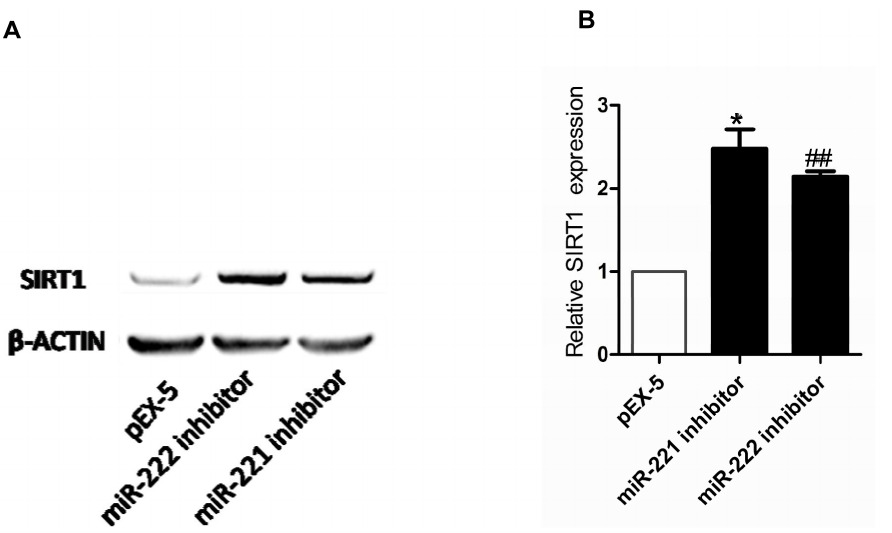
Figure 6. Effect of miR-221 inhibitor or miR-222 inhibitor on expression of SIRT1 protein. ( A ) Expression of SIRT1 protein levels in PC-3 cells after transfection were determined by Western blot analysis. ( B ) Quantitation of SIRT1 protein expression. Data represent the mean value 6 SEM from three separate experiments. * P , 0.05 vs pEX-5, ## P , 0.01 vs pEX-5.